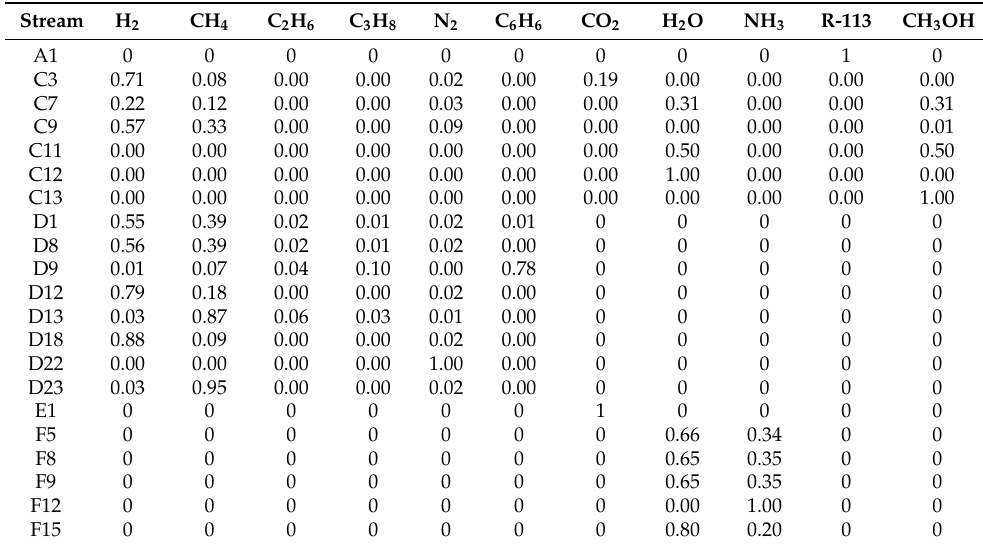
Table 1. Compositions of some important streams